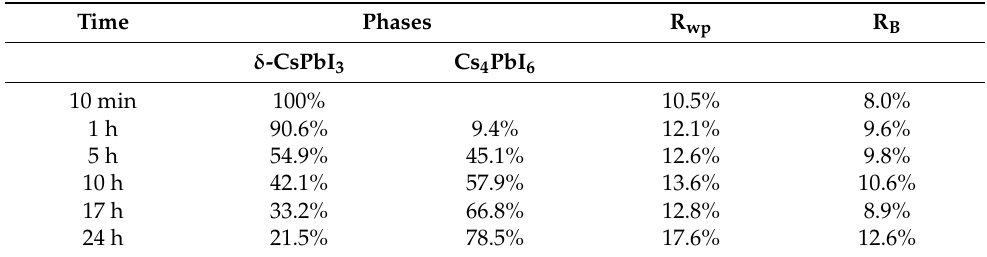
Table 1. Results of Rietveld refinement on CPI3 samples at room temperature.